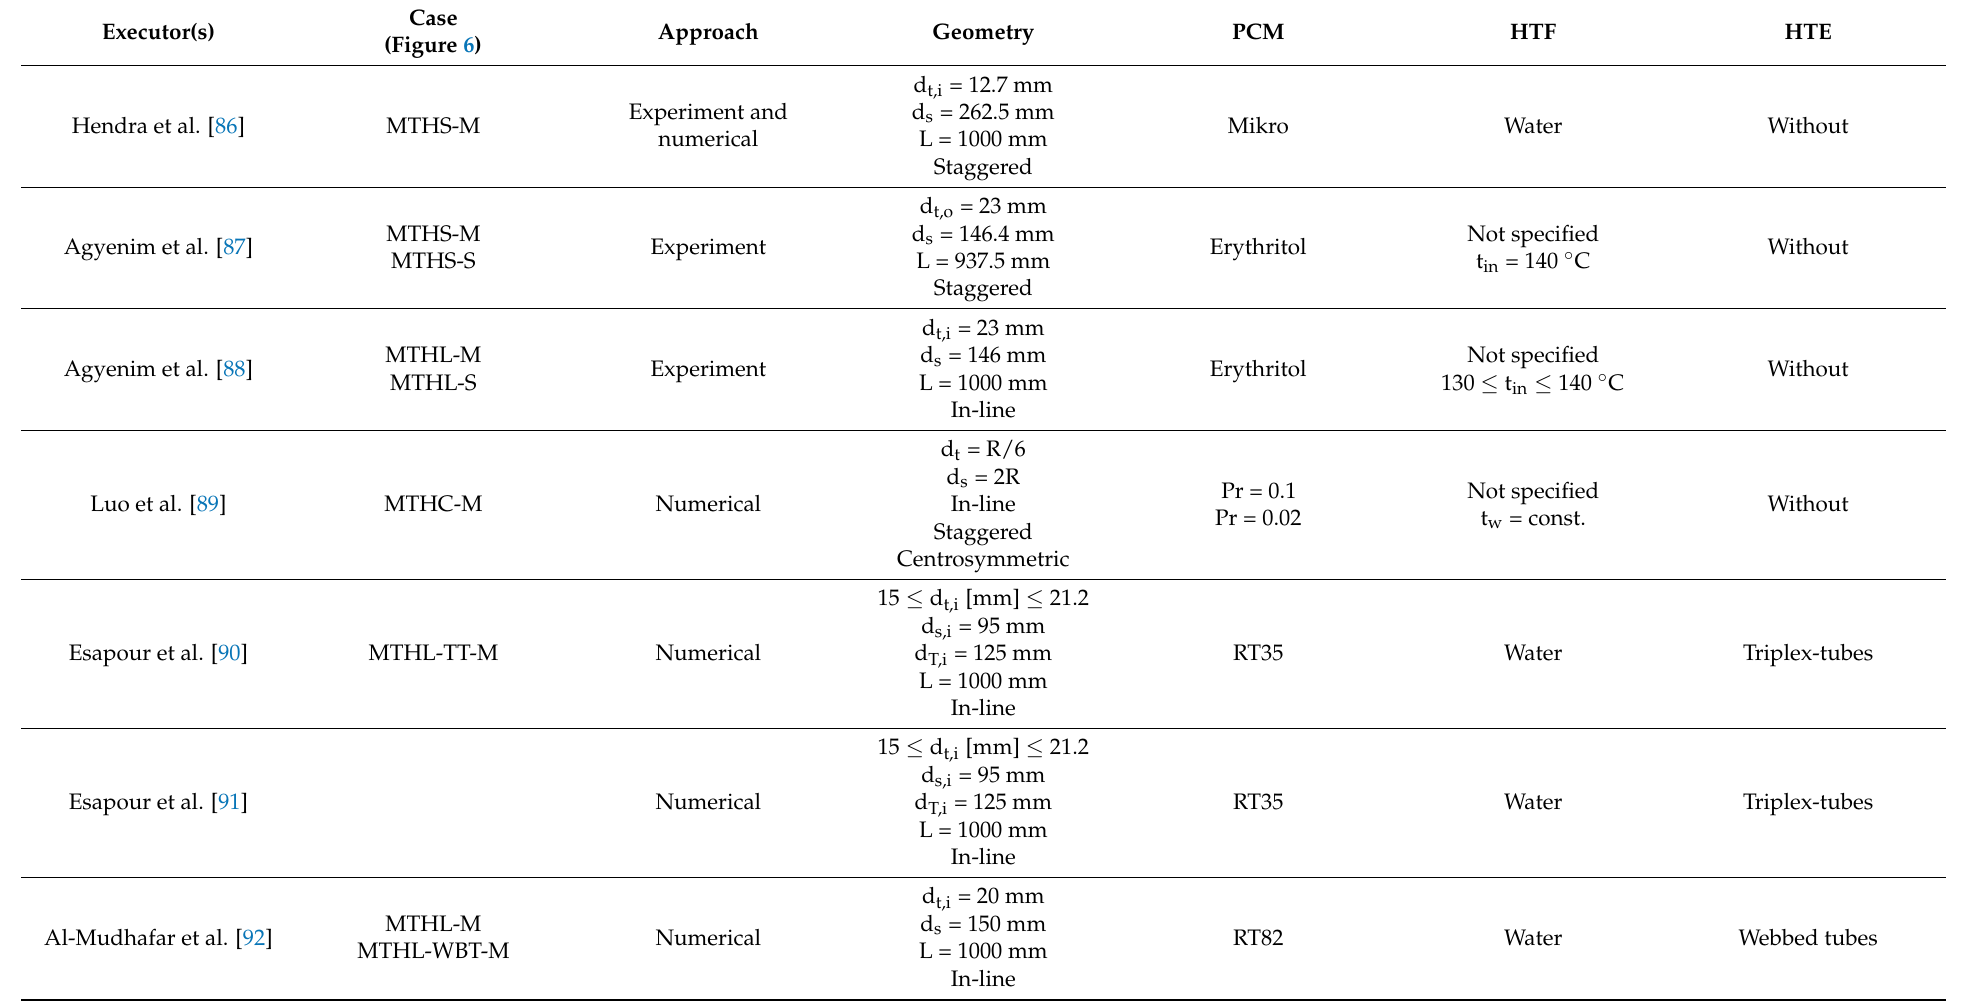
Table 6. Studies dealing with horizontal multi-tube